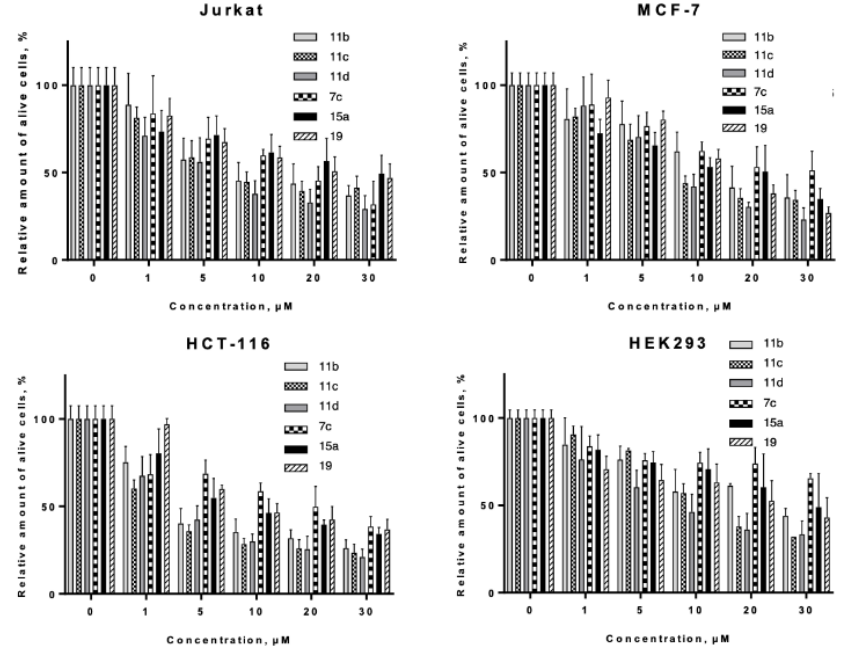
Figure 6. Comparison of cytotoxic activity of selected CK2-HDAC dual inhibitors ( 7c , 11b, 11c, 11d, 15a and 19 ) towards human leukemia (top left), carcinoma (top right and down left,) and pseudonormal (down right) cell lines. Trypan blue assay, 24 h incubation. Means and SD of at least three experiments in triplicate are shown.